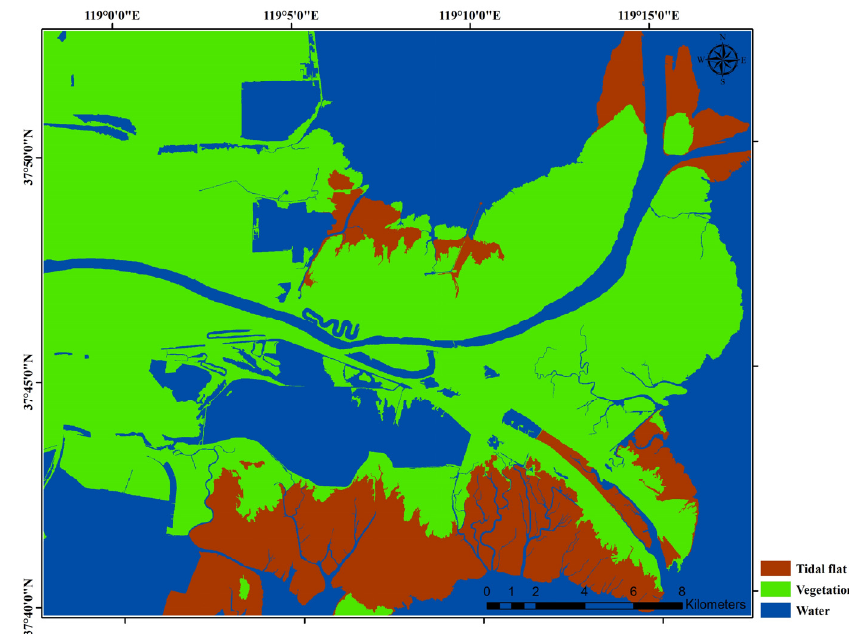
Figure 4. Classification of vegetation, tidal flat, and water.